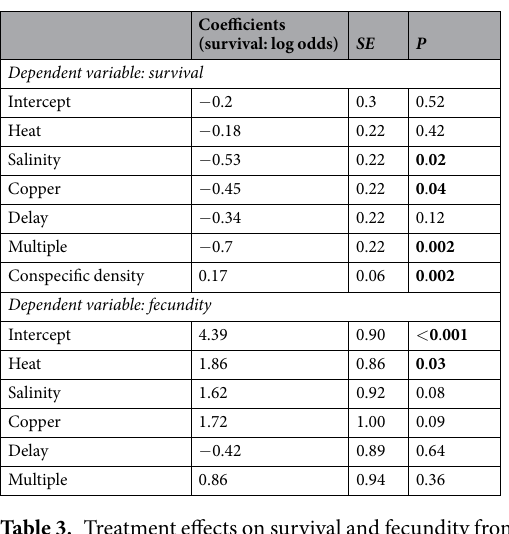
Table 3. Treatment effects on survival and fecundity from multiple logistic regression and GLM. P-values below 0.05 are highlighted by bold lettering.